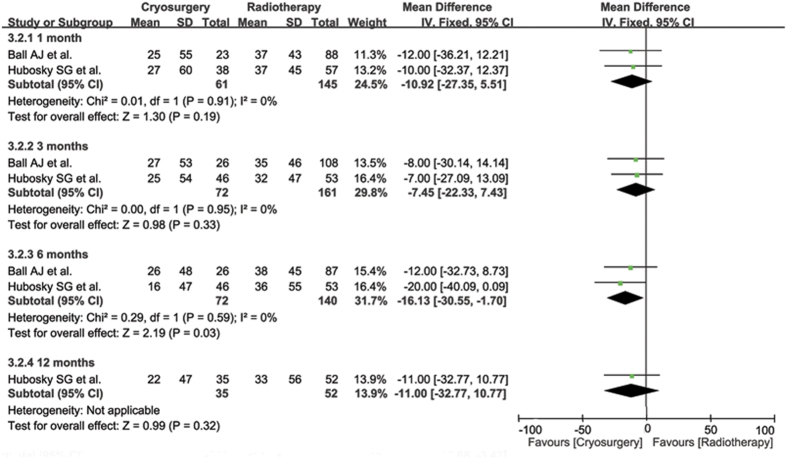
Dynamical forest plot and meta-analysis of UCLA PCI scores focusing on sexual bother in comparisons of CS vs RT in months of 1, 3, 6 and 12, respectively.